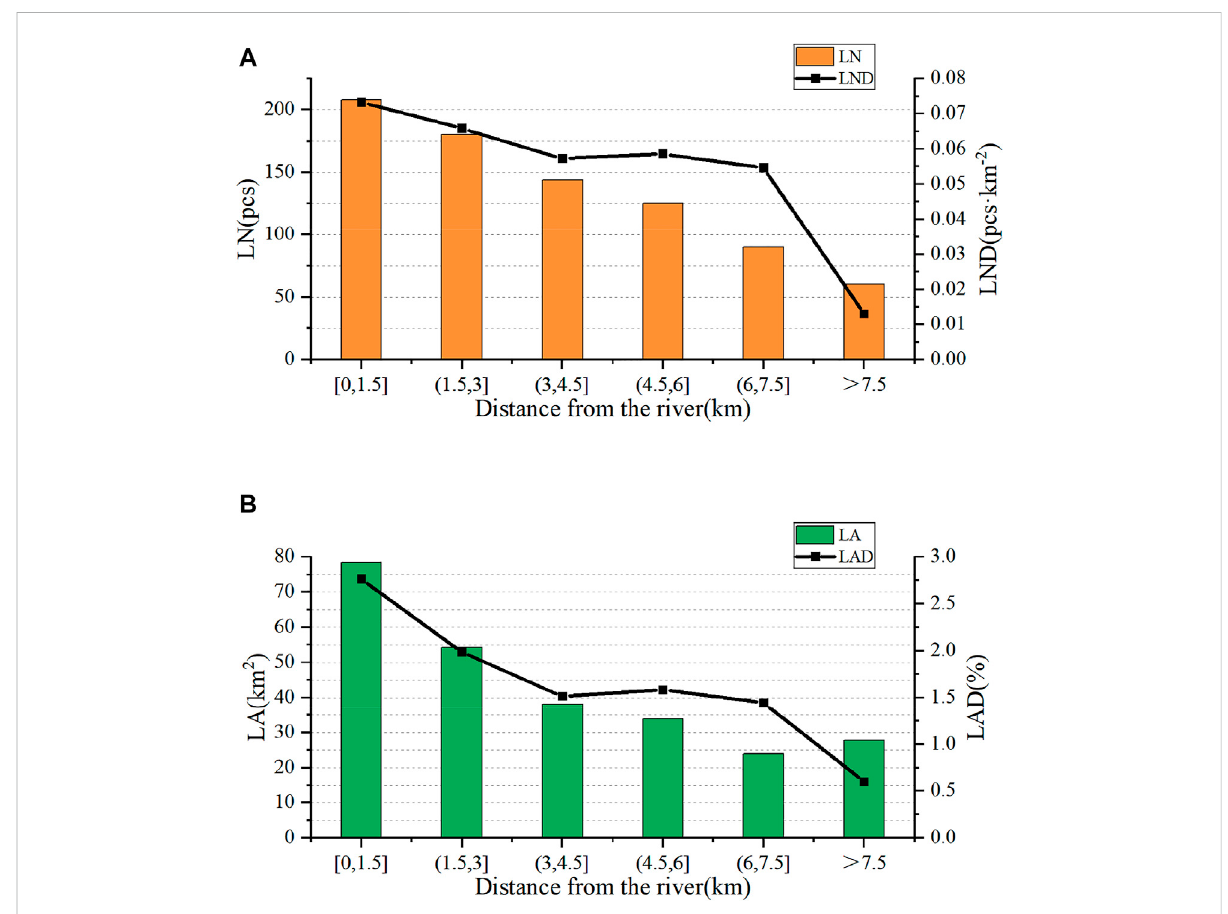
FIGURE 9 The correlations between distance from the river and landslide distribution. (A) LN and LND; (B) LA and